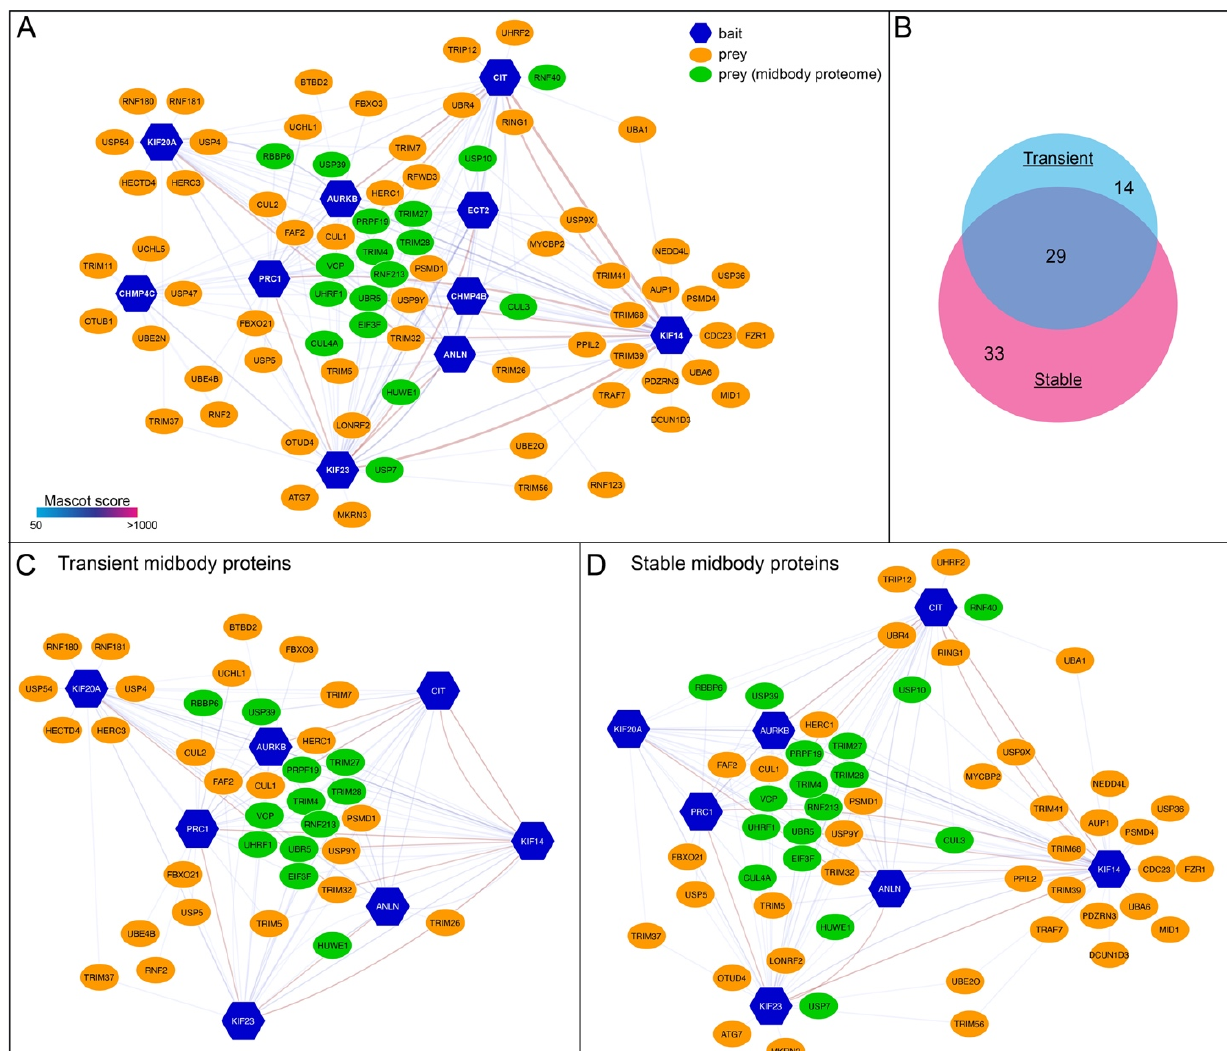
Figure 4. ( A ) Diagram illustrating the midbody ubiquitylation interactome. The entire dataset of the midbody interactome published in our previous study [11] was searched for proteins whose Uniprot protein names field contained the term ‘ubiquitin’ to generate the midbody ubiquitylation interactome shown in ( A ). Baits are indicated with blue hexagons, while preys are represented as ovals, either in green, if they were also found in the midbody proteome, or in orange, as in our previously published network [11]. The edges connecting the network nodes are colored according to their Mascot scores as indicated in the color scale bar at the bottom left (see also [11]). Preys shared by multiple baits are clustered in the center. ( B ) Proportional Venn diagram showing the number of proteins present in the transient and stable midbody ubiquitylation interactomes. ( C , D ) Diagrams illustrating the midbody ubiquitylation interactomes generated using either transient ( C ) or stable ( D ) midbody proteins as baits. Baits, preys and edges are as in ( A ). See Table S1 for a list of the proteins present in the